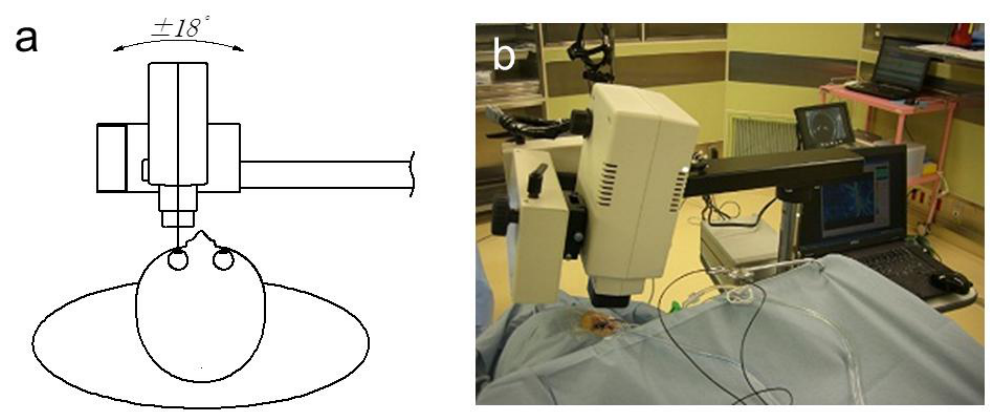
Figure 4. The schematic view ( a ) and photograph ( b ) of the recently developed LSFG-NAVI-OPE device, which is a modification of the